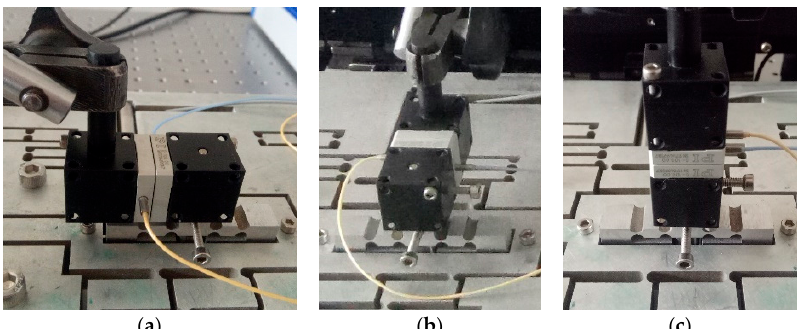
Figure 25. Experiment of device response performance test.